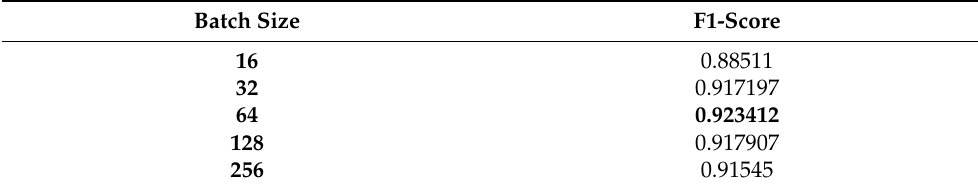
Table 7. F1-score for different batch